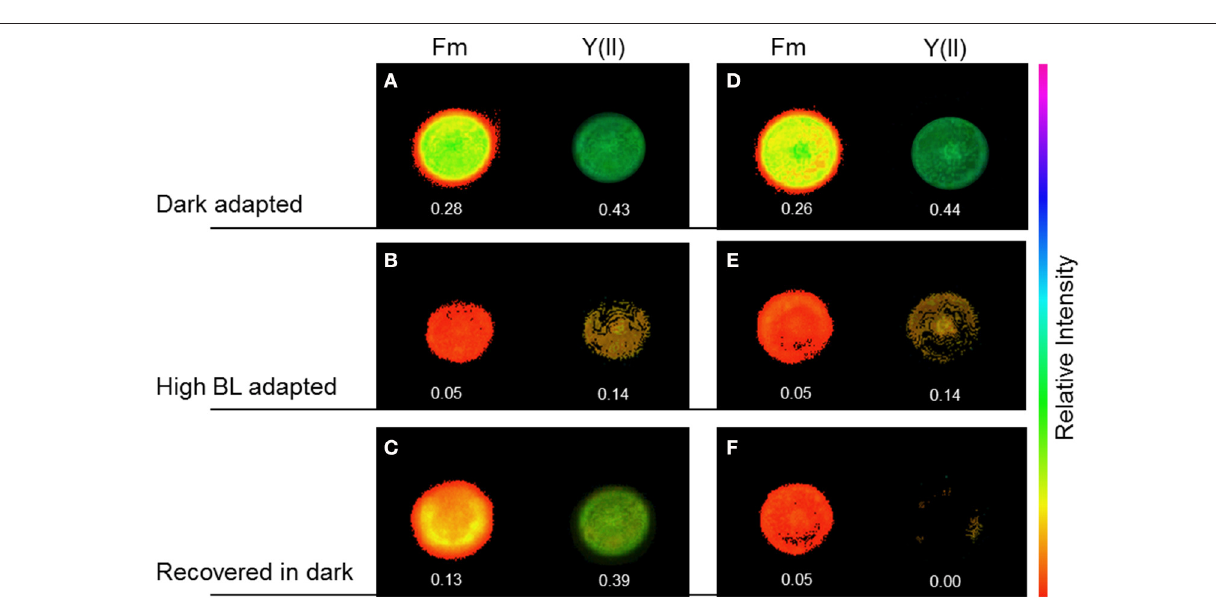
FIGURE 6 | Maximal chlorophyll fluorescence yield, F m ′ , and effective PSII quantum yield, Y(II), in Coscinodiscus granii cells during alteration of the chloroplast arrangement under high BL photon irradiance. In cells with an even chloroplast distribution (ECD) (A–D) , Y(II) decreased upon illumination with BL for 30min (B) and recovered after 30min in the dark (C) . After an alteration of the chloroplast distribution, Y(II) decreased after illumination with BL for 30min (E) and did not recover after 30min in the dark (F)